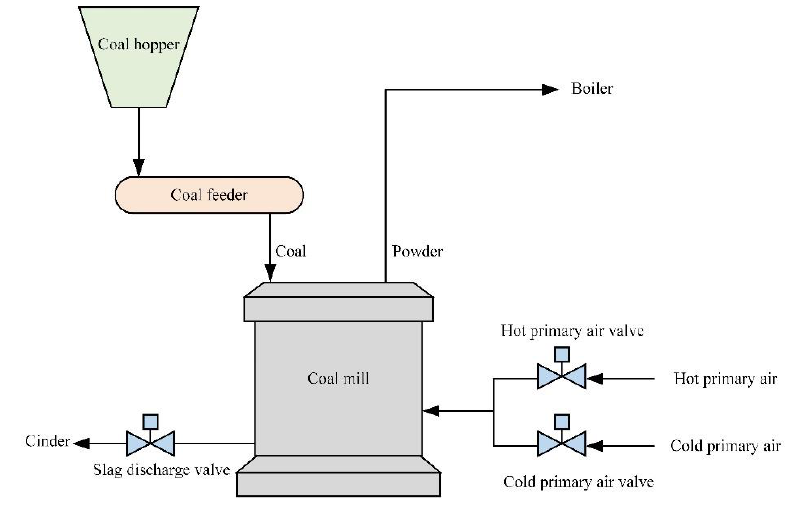
Figure 5. Schematic diagram of a simplified coal mill process.